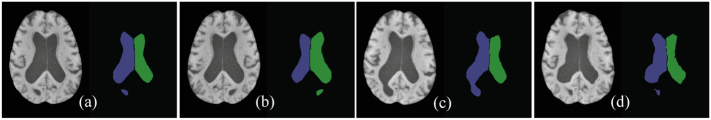
Data augmentation examples (MRI and the corresponding label image). (a) The original image; (b) Left-right flipping; (c) Random rotation; (d) Elastic deformation.